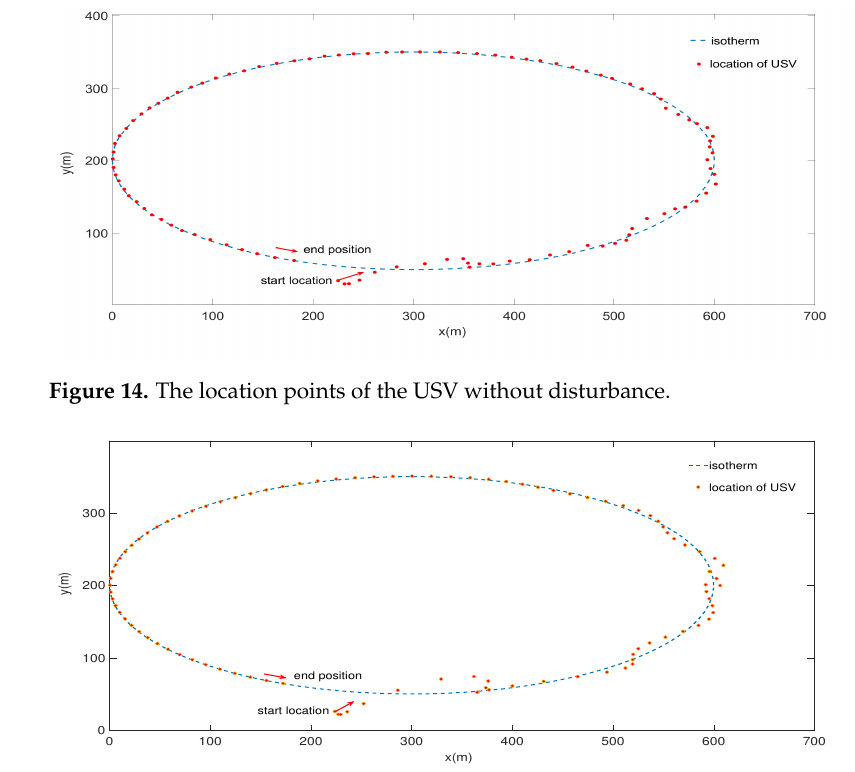
Figure 15. The location points of the USV under disturbance. Table 3. Error table between actual track and target track of the USV.